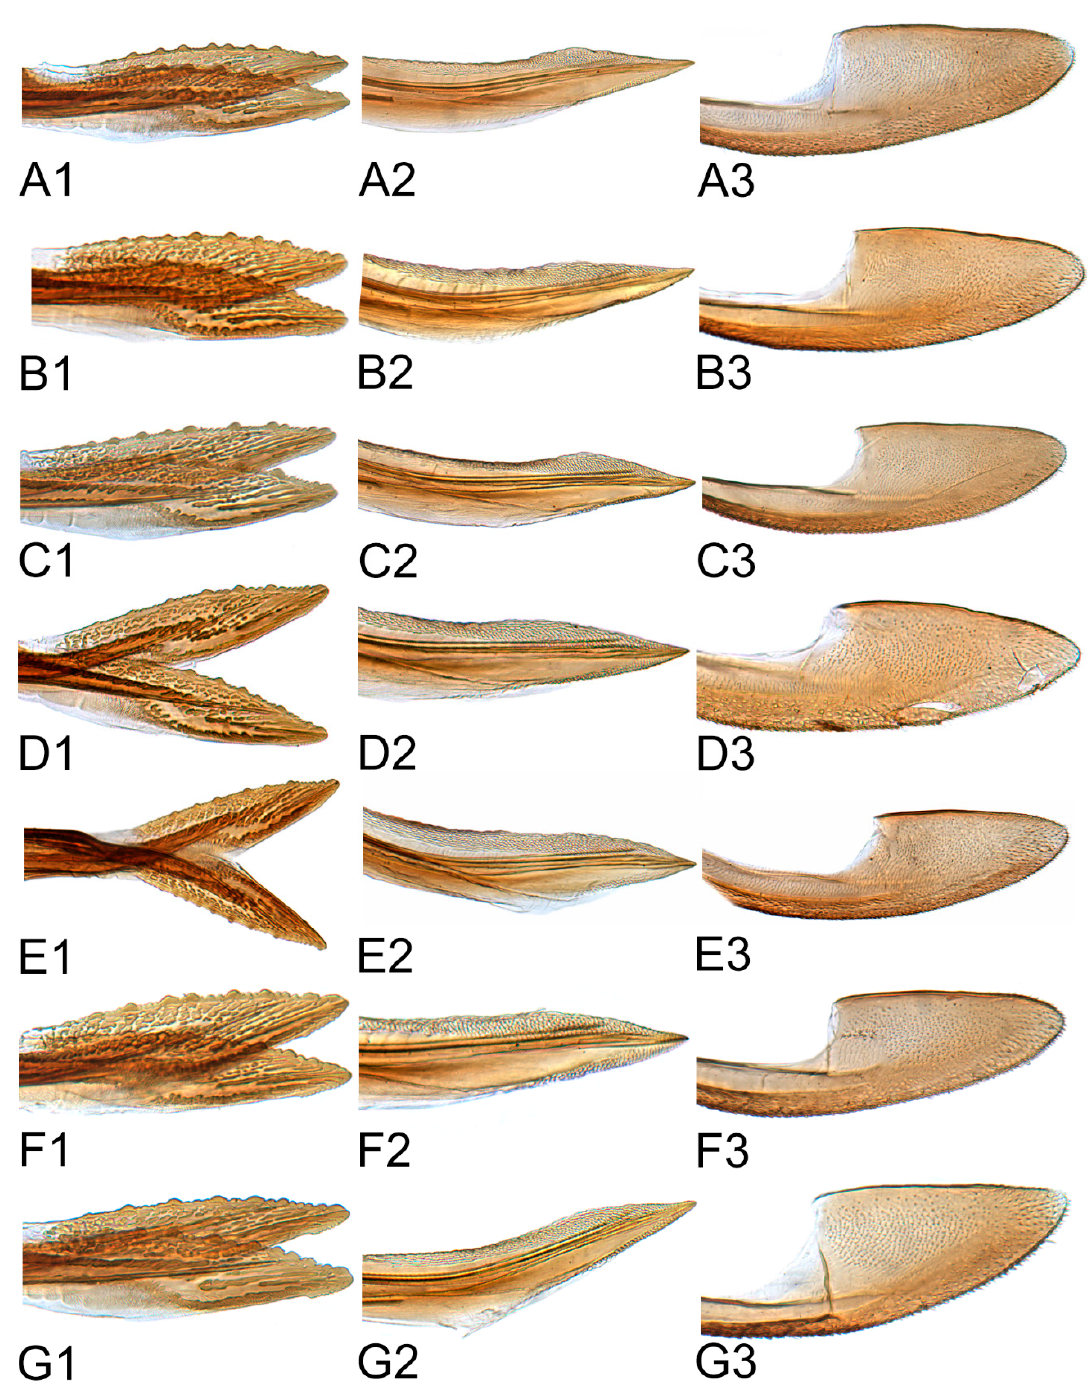
Figure 25. Dissected parts of ovipositor, showing detail of second, first, and third valvulae apex. ( A1 – A3 ) H. hamuleus ; ( B1 – B3 ) H. hamatus ; ( C1 – C3 ) H. fuscomaculatus ; ( D1 – D3 ) H. phycitis ; ( E1 – E3 ) H. paraphycitis ; ( F1 – F3 ) H. viraktamathiellus ; and ( G1 – G3 ) H. triangulus .